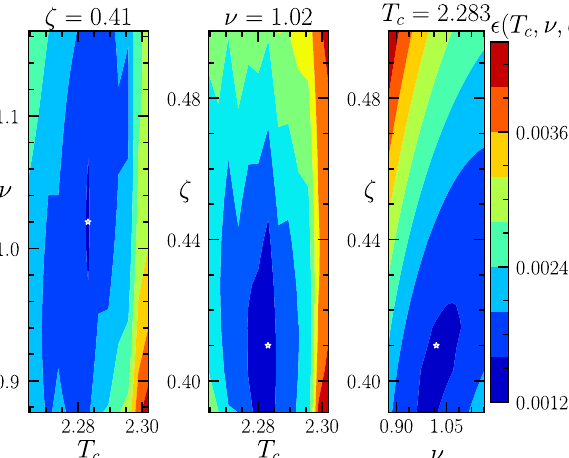
(2019).FIG. 14. Contour plot of the average residuals projected on the direction of the optimal parameters for the Ising model. The white star points to the optimal parameters for our finite-size analysis.